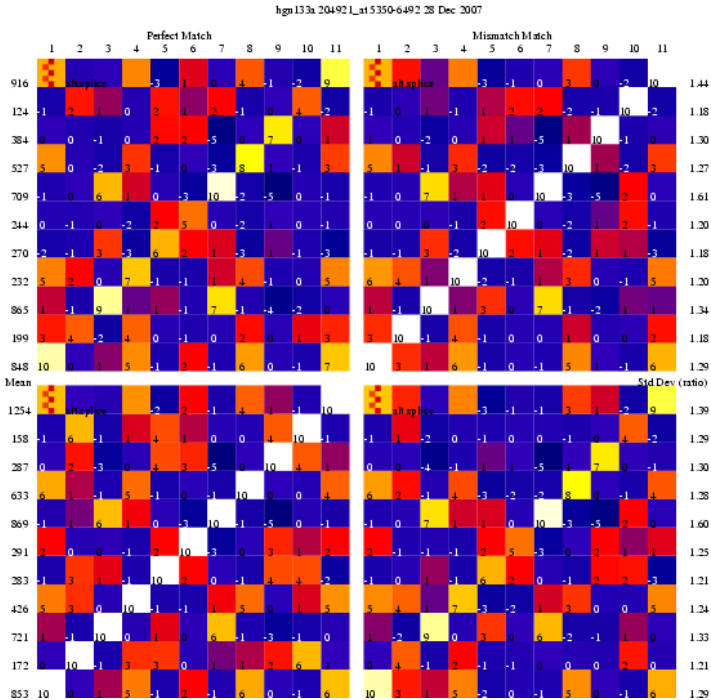
Figure 9: The correlation in intensities (log2) for probes in probeset 204921 at on HG-U133A. For this probeset there is little correlation between any of the probes – this indicates that this probeset will be